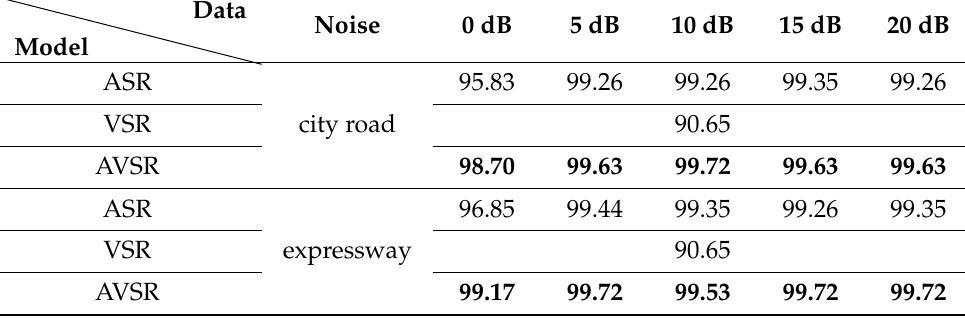
Table 5. AVSR accuracy (%) in various noise conditions with ASR and